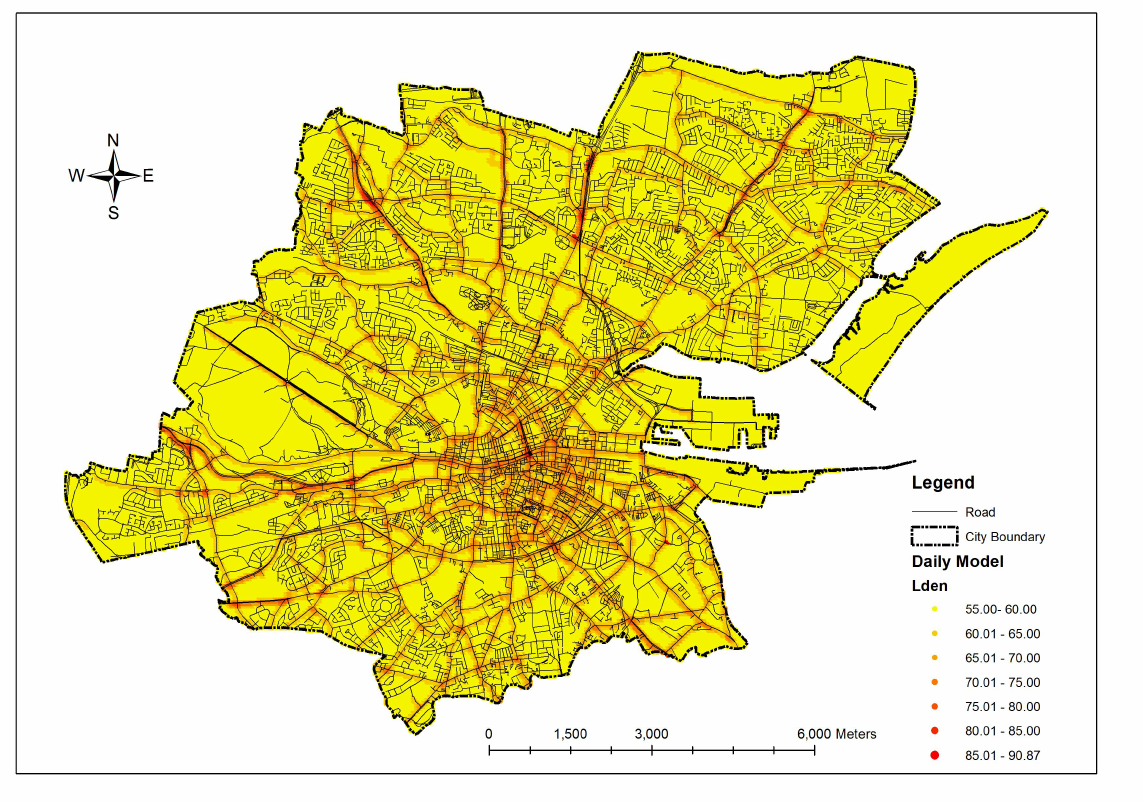
Figure 3: Map showing spatial variation of L den , derived from Daily D model